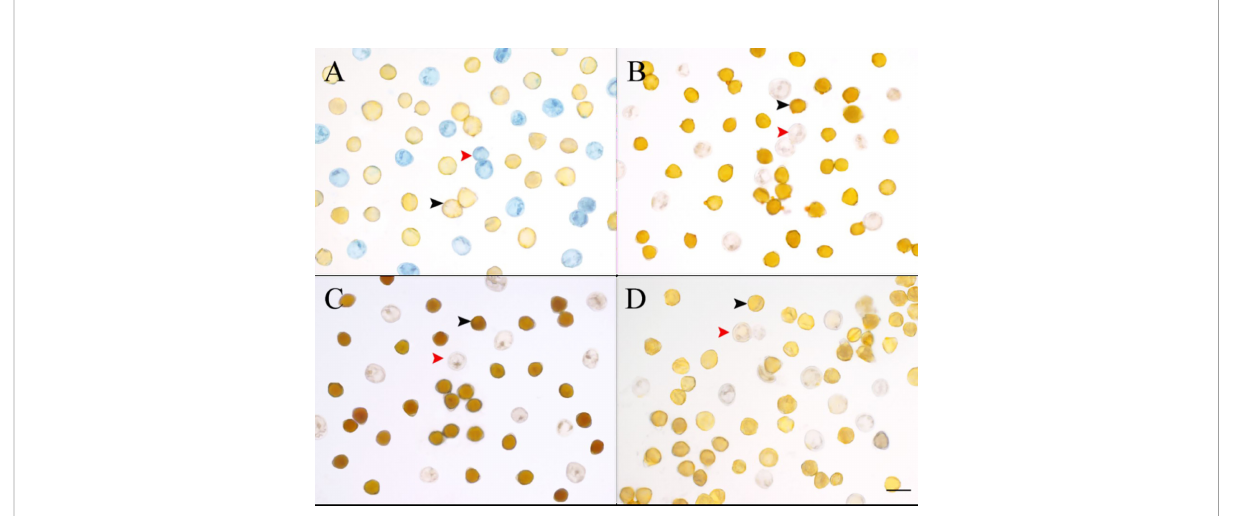
FIGURE 6 Comparison of four stains for normal pollen and pseudopollen of Camellia oleifera . (A) Coomassie Brilliant Blue. (B) Sudan III. (C) I-KI. (D) Control group. The black arrow indicates normal pollen; the red arrow indicates pseudopollen. Bar = 50 m